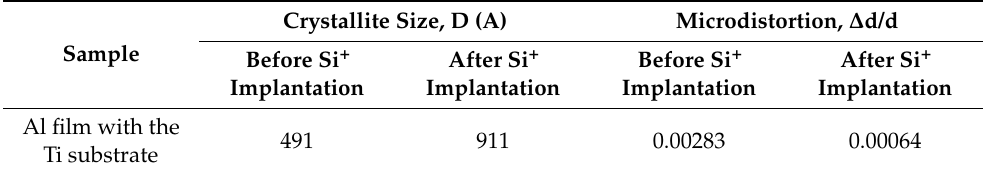
Table 2. Results of X-ray structural analysis after annealing at 600 ◦ C; along the Al 3 Ti plane